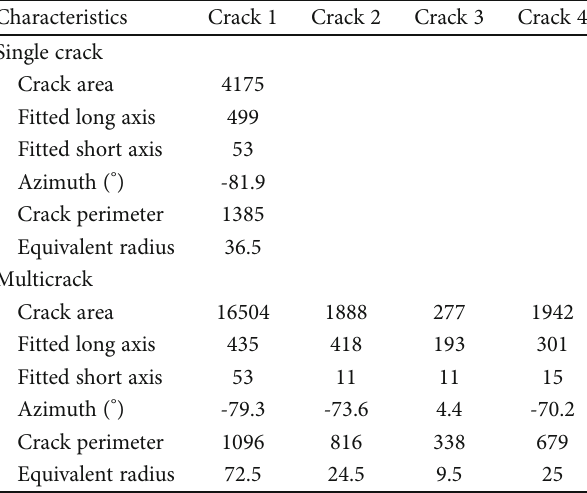
Table 2: Two-dimensional information of the crack (unit: pixel). Characteristics